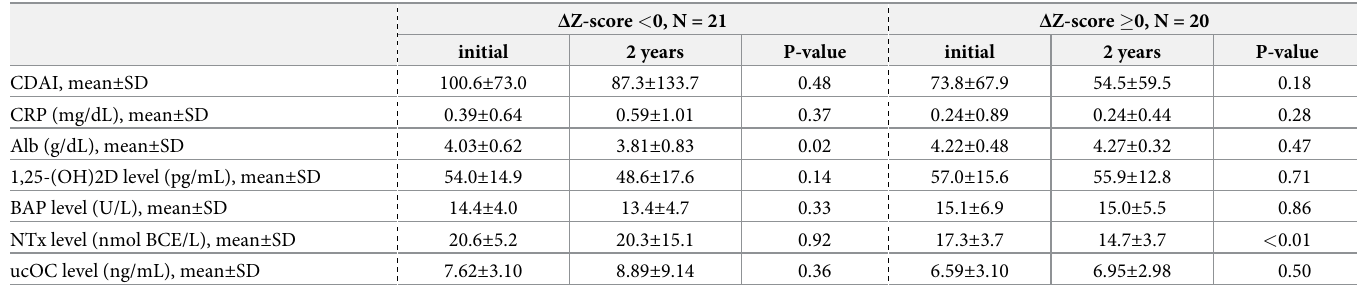
Table 6. Comparison of initial and secondary measured biomarkers